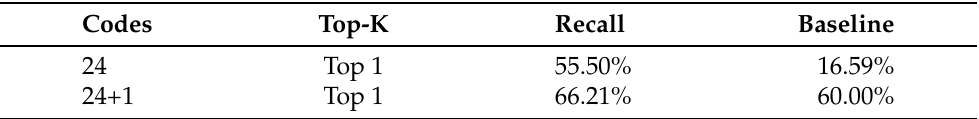
Table 9. Experiment results of